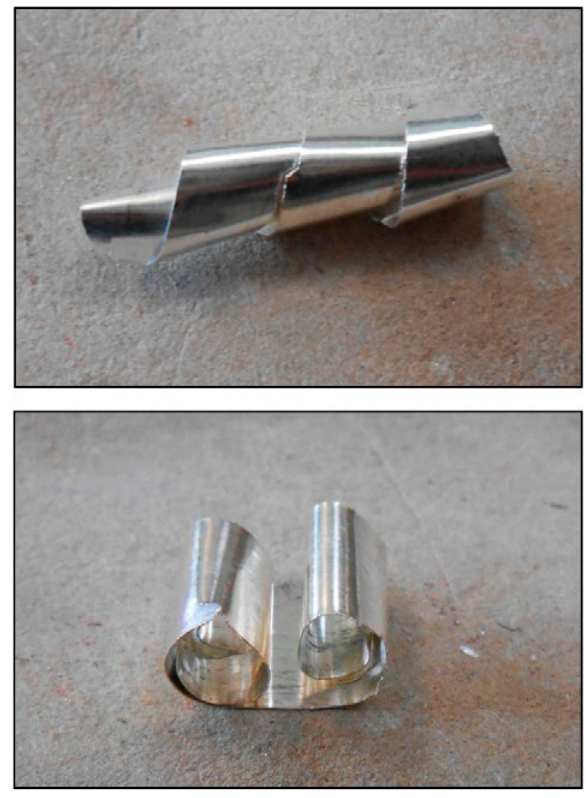
Figure 2. Cornet (top) and volute shapes (bottom) in the same rolled cupellation